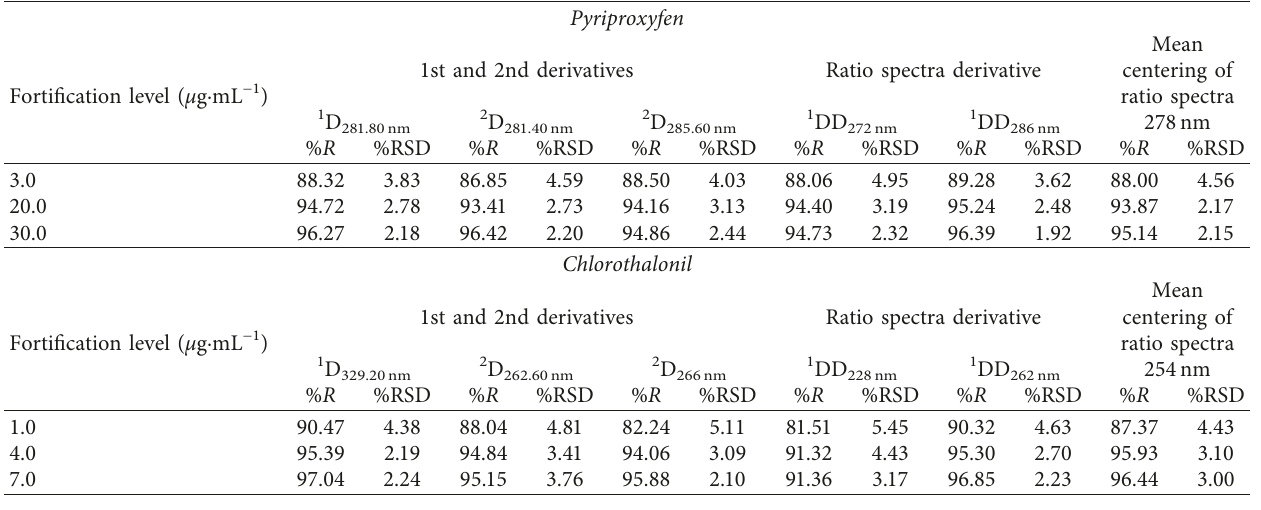
Table 3: Percentage mean recovery of pyriproxyfen and chlorothalonil in real cucumber samples by proposed methods.